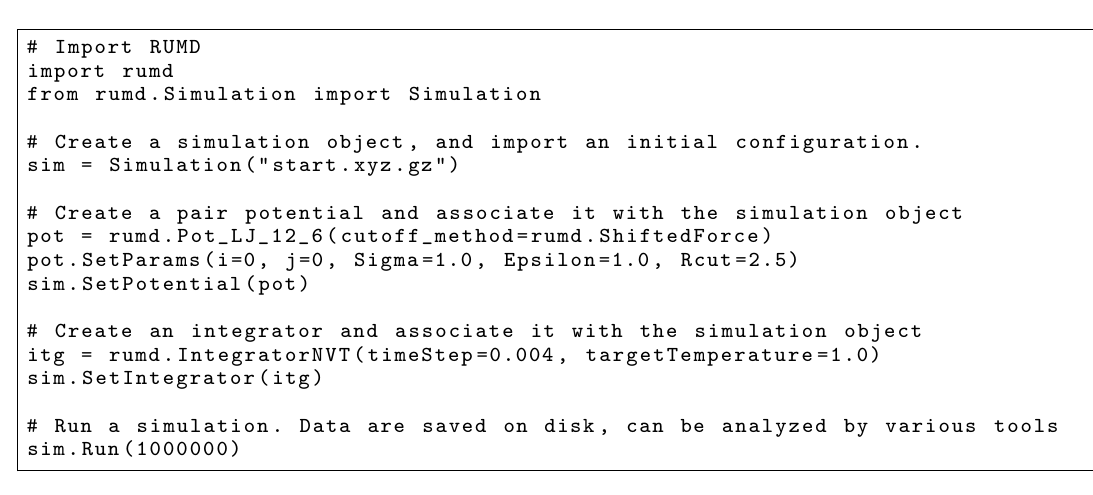
Figure 1: Script showing the Python code needed to run a simple simulation, in this case a single-component Lennard-Jones fluid simulated at constant temperature 1.0 for one million time steps of size 0.004 (Lennard-Jones units). The number of particles and the density is determined by the initial configuration contained in the file